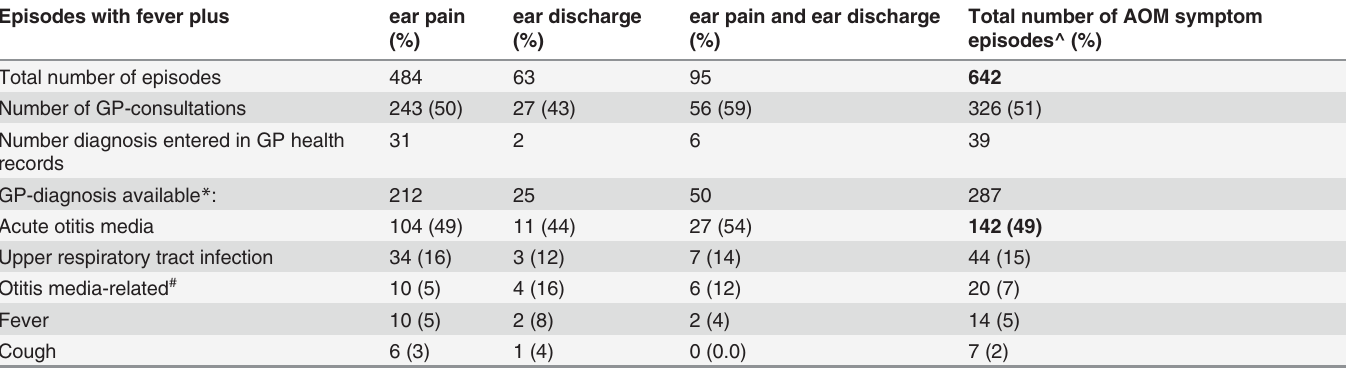
Table 3. Characteristics of all febrile AOM symptom episodes stratified by